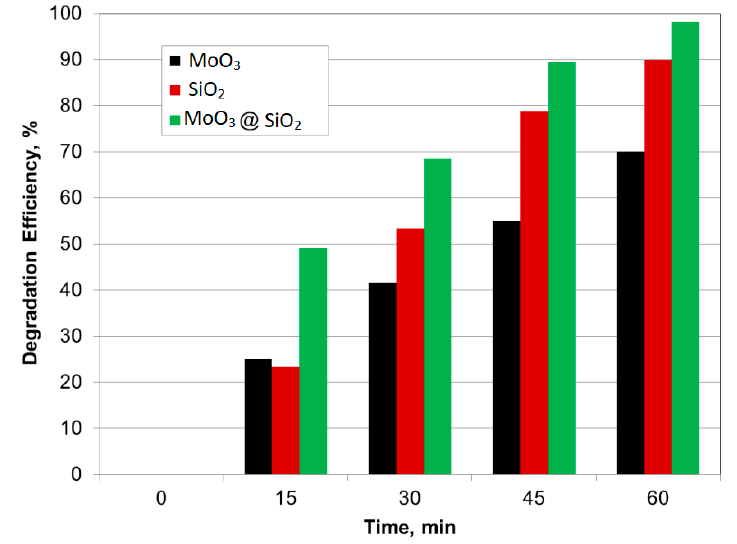
Figure 5. Comparative bar diagram of degradation efficiency for MoO 3 , SiO 2, and MoO 3 @ SiO 2 .